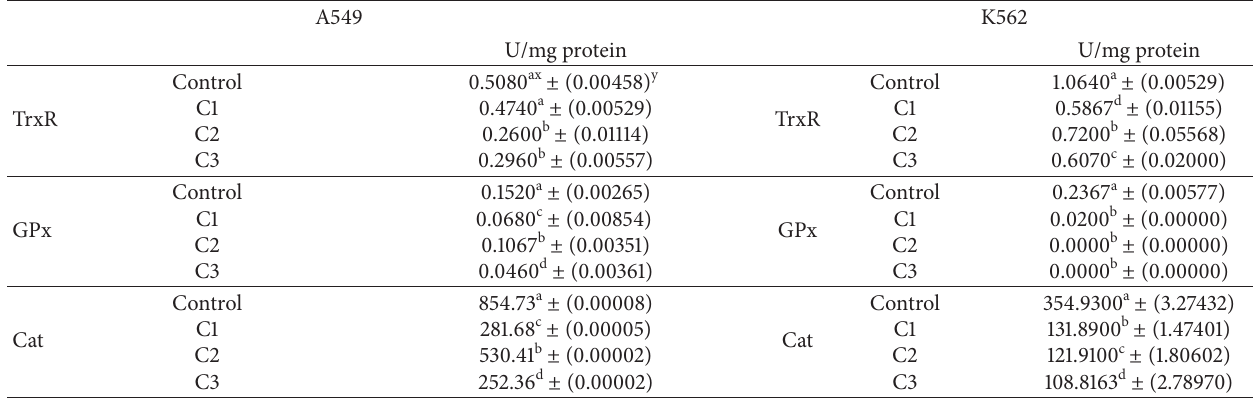
Table 1: Specific activities of TrxR, GPx, and Cat enzymes in the given period, after incubation of A549 and K562 cells, with IC metal